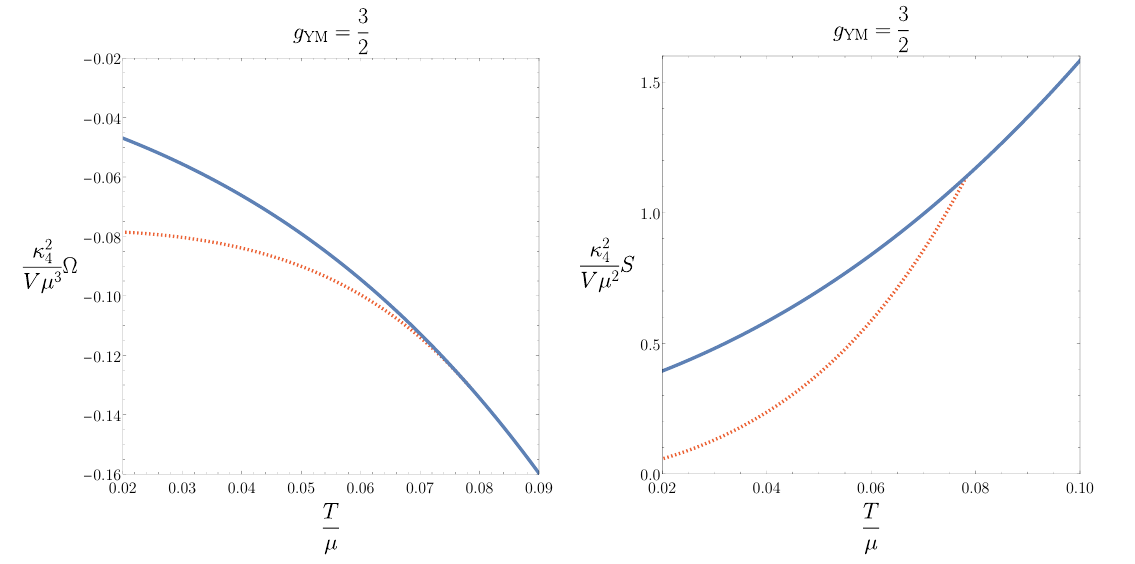
Figure 8. The grand potential Ω as a func- Figure 9. The entropy S as a function of tion of temperature for both normal and con- temperature for both normal (blue) and con- densed phase with g YM = 3 / 2 . The red dashed densed (red, dashed) phase with g YM = 3 / 2 . curve (condensed phase, h J x i 6 = 0 ) and the blue At T = T c , the red curve is continuous but non- 1 curve (normal phase, h J x i = 0 ) smoothly inter- differentiable. The behaviour exhibited is there- 1 sect showing that Ω is both continuous and dif- fore that of second order phase ferentiable.